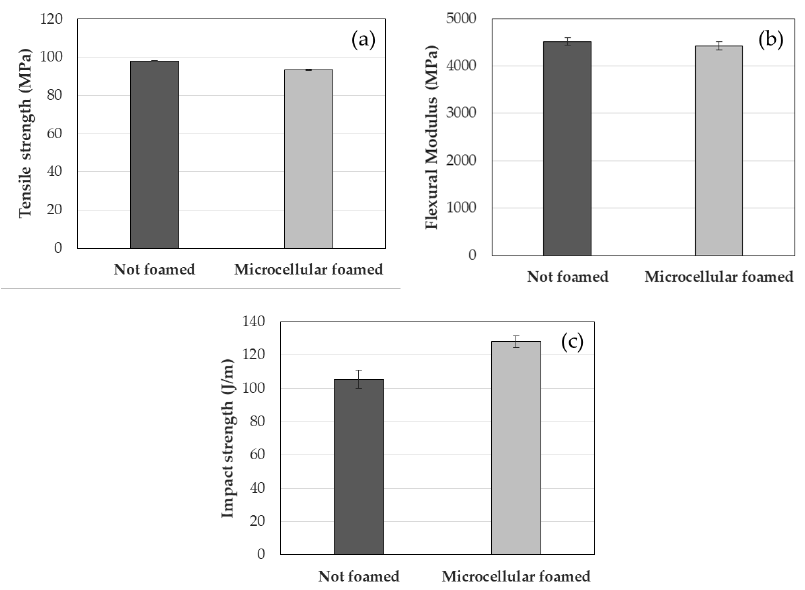
Figure 8. Measured shrinkages in the flow direction and the transverse direction.